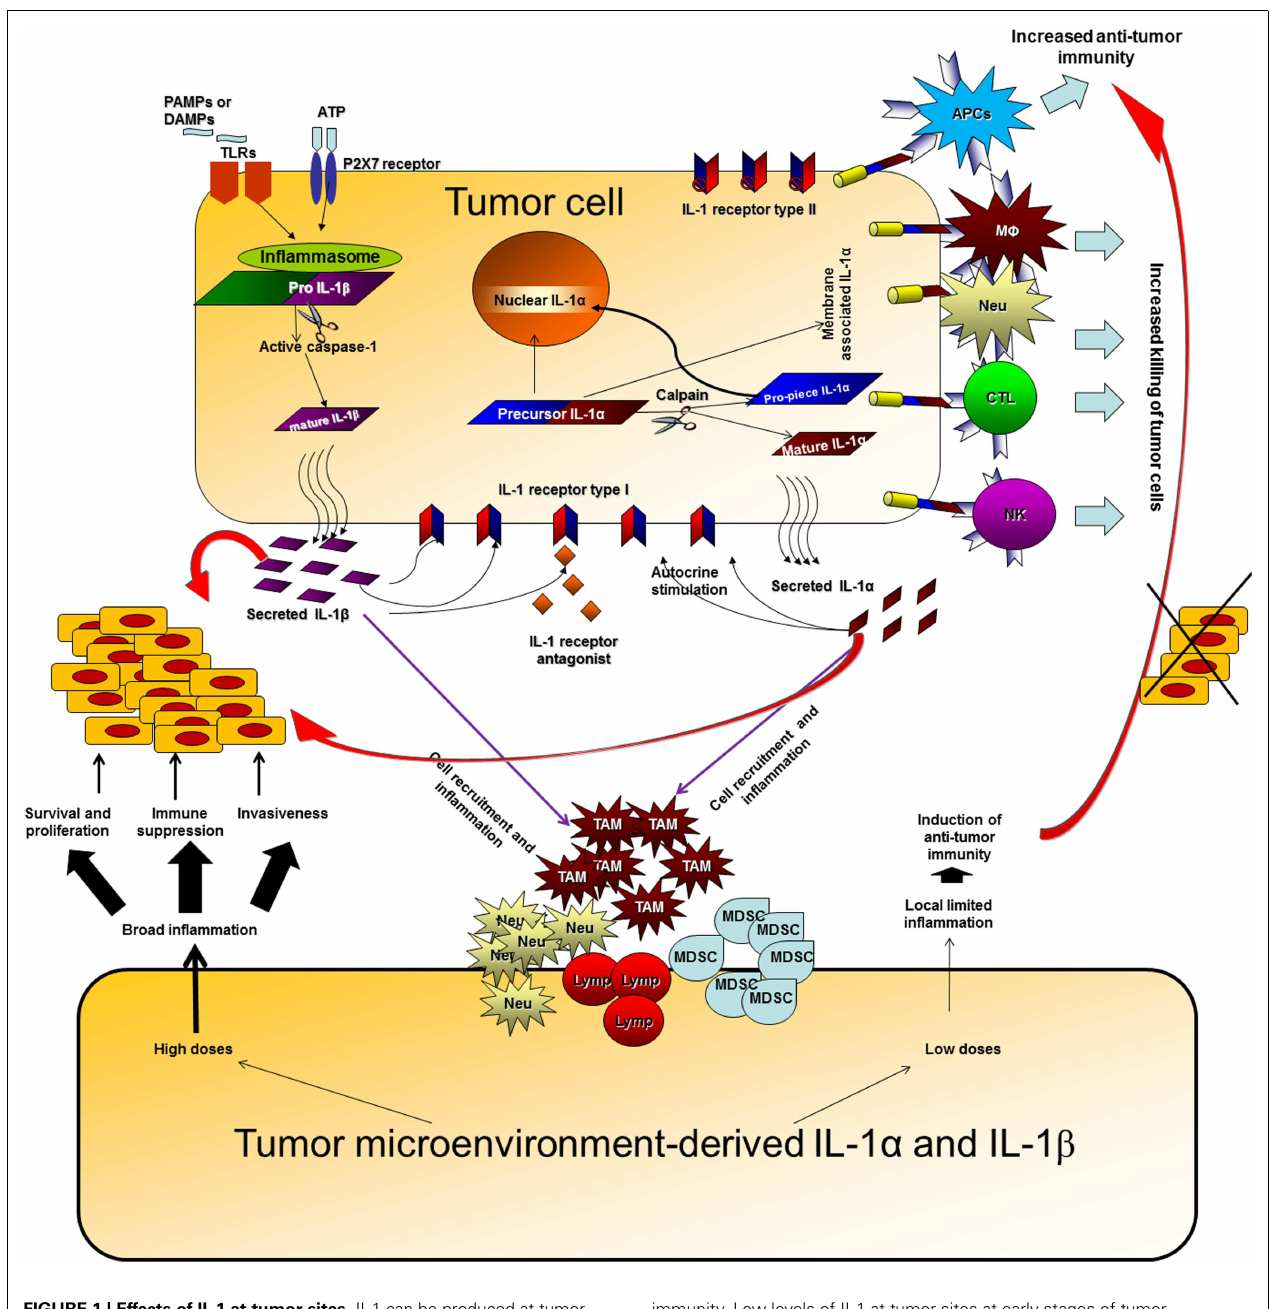
FIGURE 1 | Effects of IL-1 at tumor sites . IL-1 can be produced at tumor sites by the malignant cells or by diverse cells in the tumor microenvironment. IL-1 generated by tumor cells can affect the malignant cells in an autocrine or paracrine manner, enabling proliferation, and invasiveness. In parallel, IL-1 secreted by malignant cells activates microenvironment residing or infiltrating cells to produce additional IL-1, which then induces a cytokine network, which further activates tumor invasiveness. High doses of IL-1 at tumor sites usually result in an invasive potential and immunosuppression. Expression of IL-1 α on the membrane of malignant cells increases their immunogenicity and leads to induction of efficient anti-tumor responses. Membrane IL-1 α expressed on infiltrating cells possibly also promotes the development of anti-tumor cell